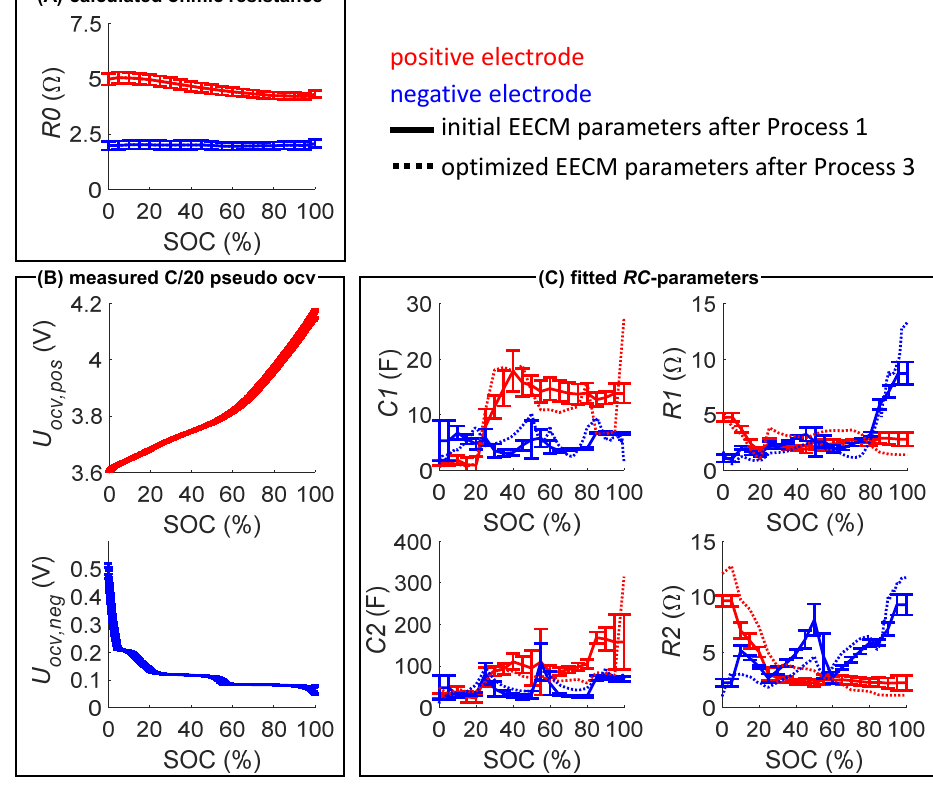
Figure 3. Determined parameter set of the Electrode Equivalent Circuit Model (EECM) for the given cell configuration. The initial parameter set is obtained after Process 1. ( A ) The ohmic resistance R0 is calculated by Ohm’s Law based on the current-interrupt test. ( B ) The pseudo open circuit voltage (ocv) curves ( U ocv,pos and U ocv,neg ) are received by the C/20 measurement. The voltages of both electrodes are measured versus the lithium reference electrode. ( C ) The parameters of the RC branches are obtained by the fitting processes (Process 1 to Process 3). The optimized parameter set is obtained after Process 3 and is the basis of the validation. Besides R0 , all parameters show strong SOC